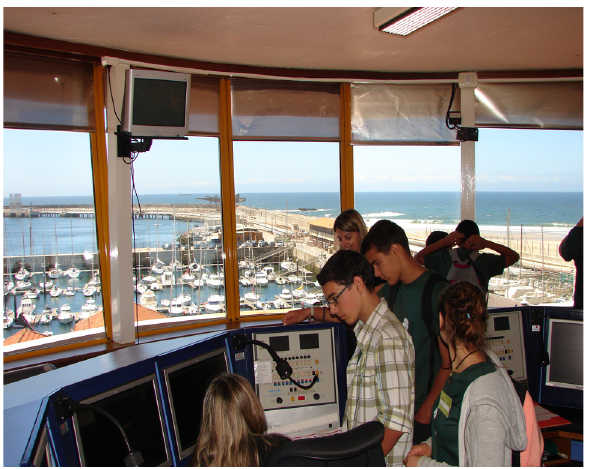
Figure 4. Geographical origin of U.Jr. participants and U.Porto students